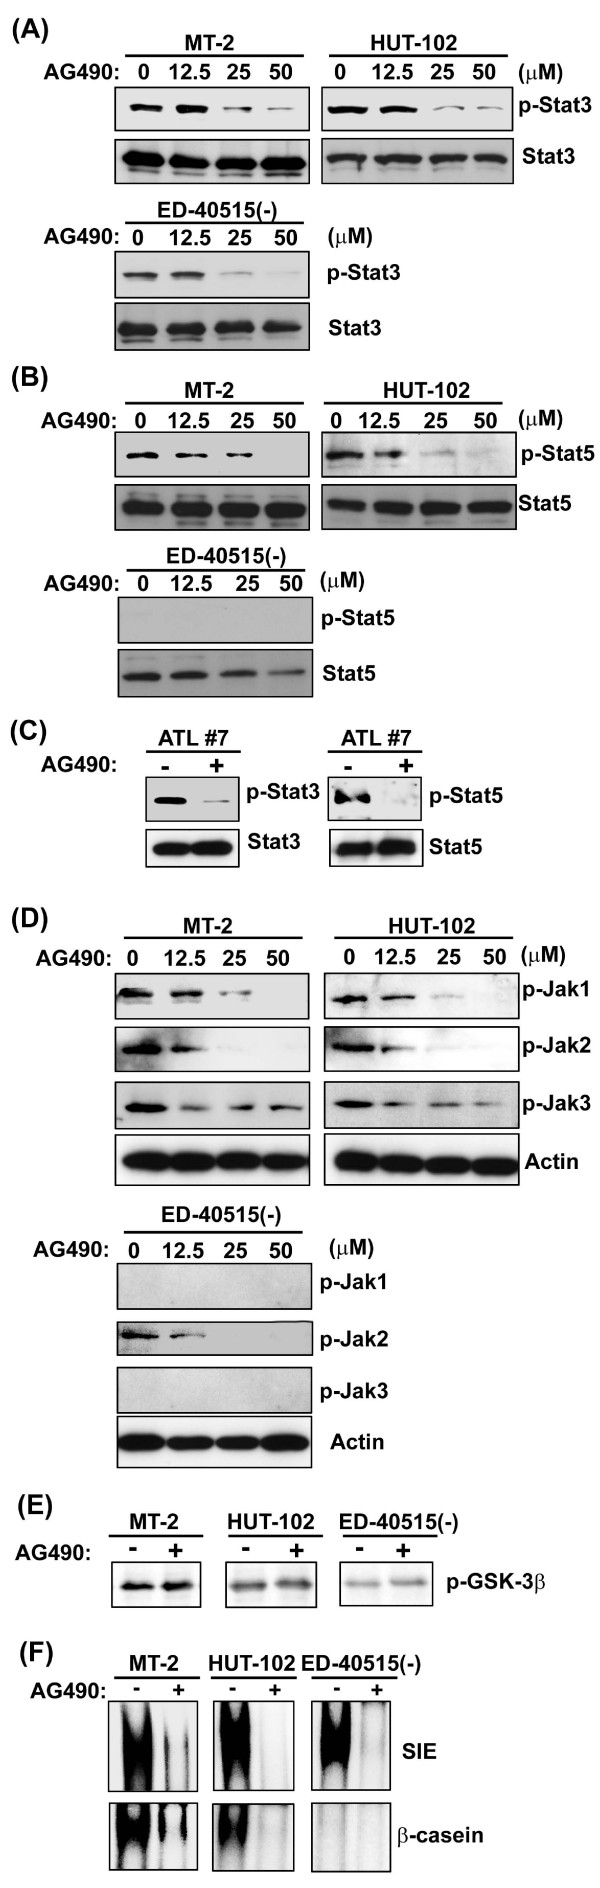
AG490 inhibits constitutive activation of Jak and Stat in HTLV-1-infected T-cell lines and primary ATL cells. (A and B) HTLV-1-infected T-cell lines were treated with increasing concentrations of AG490 for 24 h. (C) Primary ATL cells were treated with (+) or without (-) 50 μM AG490 for 24 h. Phosphorylation status of Stat3 and Stat5 was assessed by Western blot analysis. (D) HTLV-1-infected T-cell lines were treated with increasing concentrations of AG490 for 24 h. Phosphorylation status of Jak1, Jak2 and Jak3 were assessed by Western blot analysis. (E) AG490 does not affect phosphorylation of other phosphor-protein that is not regulated by Jak-Stat pathway. HTLV-1-infected T-cell lines were treated with (+) or without (-) 50 μM AG490 for 24 h. Phosphorylation status of GSK-3β was assessed by Western blot analysis. (F) AG490 inhibits constitutive Stat3- and Stat5-DNA binding in HTLV-1-infected T-cell lines. Nuclear extracts were isolated from HTLV-1-infected T-cell lines treated with (+) or without (-) 50 μM AG490 for 24 h. Stat-DNA binding activity was assessed by EMSA using SIE or β-casein probe.